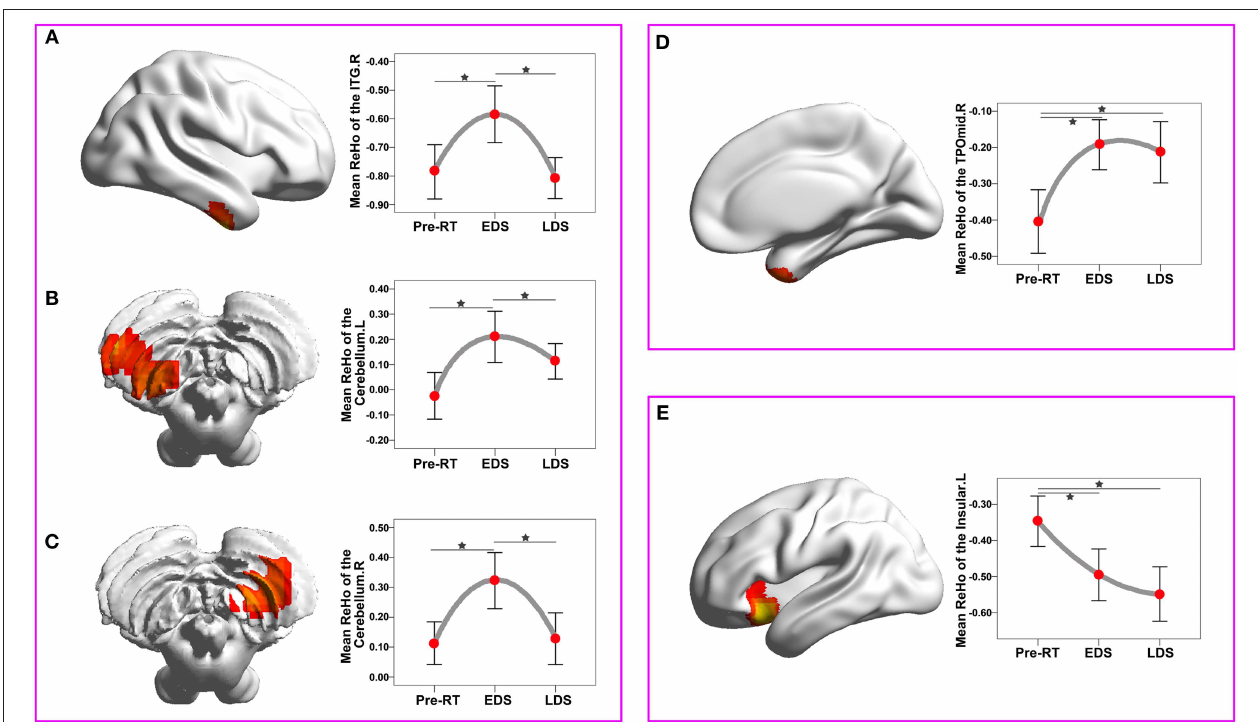
FIGURE 3 | ReHo changes among the three time points compared with a whole-brain voxel-wise based one-way repeated measure ANOVA and post-hoc tests. There were three patterns of dynamic change for the ReHo index: “increase-decrease-recover” pattern (A–C) , with full-recovery in the right cerebellum (A) and right ITGs (B) , and with partial-recovery in the left cerebellum (C) ; “increase” pattern without significant recovery in the right TPOmid (D) ; “decrease” pattern without significant recovery in the left insula (E) . Brain regions were reported at the significant level of a threshold of two-tailed voxel-wise P < 0.01 and cluster level P < 0.05 with Gaussian Random Field correction. Error bars indicate two standard errors, and pentagrams indicate significant differences revealed by ANOVA post-hoc tests with Dunnett’s tests ( P < 0.05). ANOVA, analysis of variance; EDS, early-delayed stage; L, left; LDS, late-delayed stage; ITG, inferior temporal gyrus; MNI, Montreal Neurological Institute; R, right; ReHo, regional homogeneity; TPOmid, temporal pole: middle temporal gyrus; RT, radiotherapy.